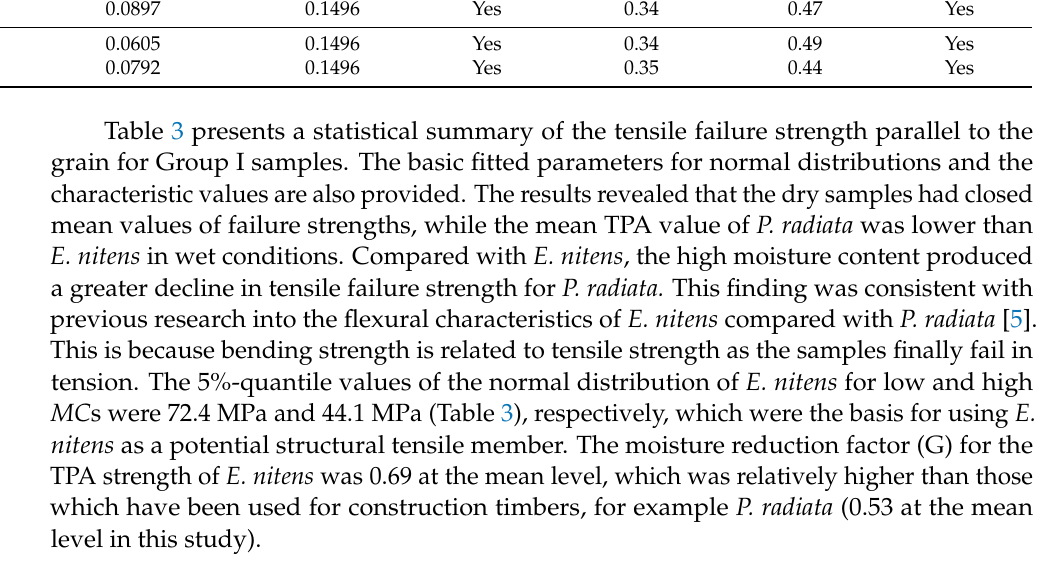
Table 3. Tensile failure strength parallel to the grain